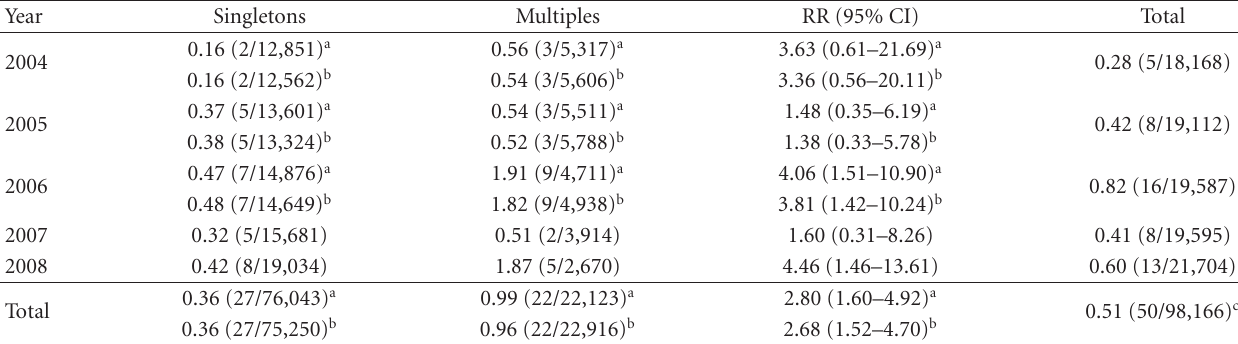
Table 4: Crude early neonatal mortality rate of birth defects (per 1,000 ART live births).